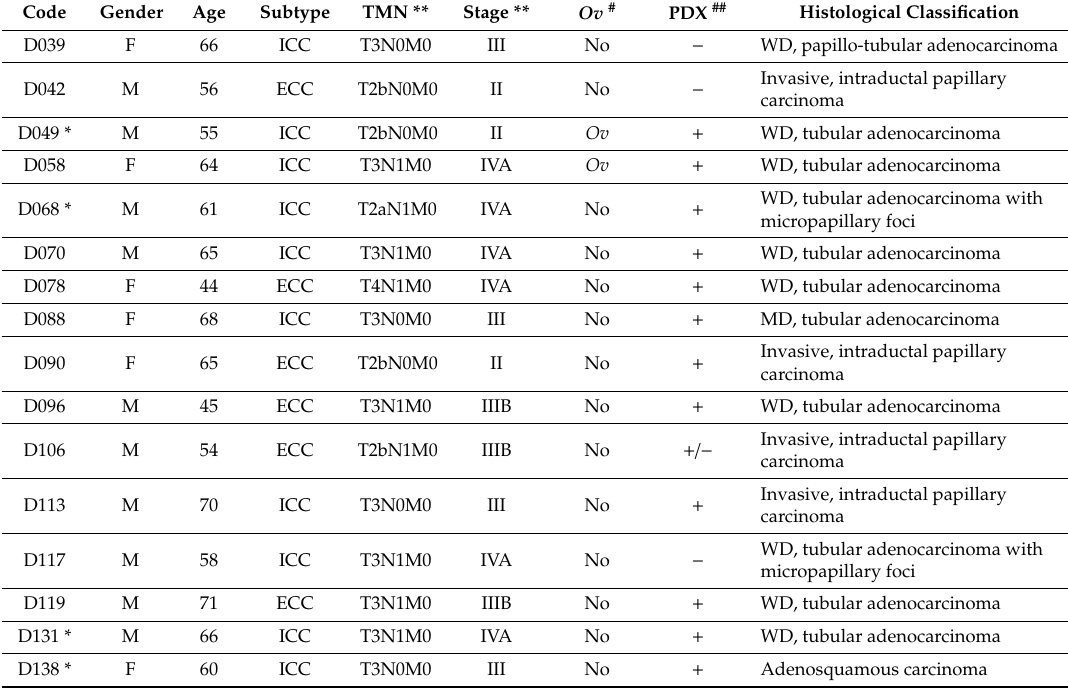
Table 1. Characteristics of patients and cholangiocarcinoma